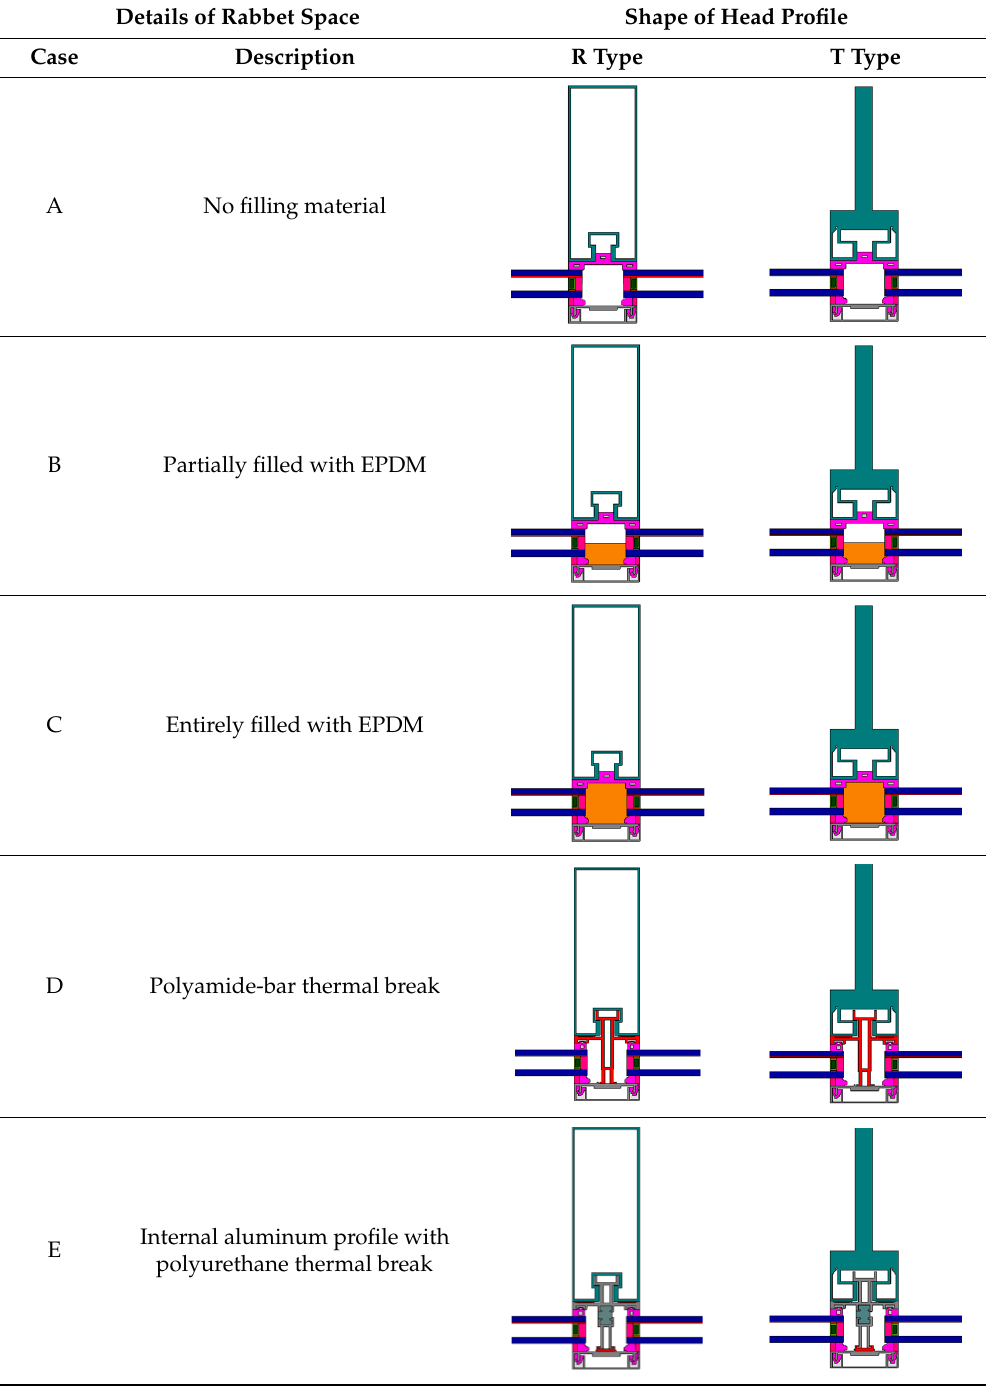
Table 5. Description of base cases for evaluation.